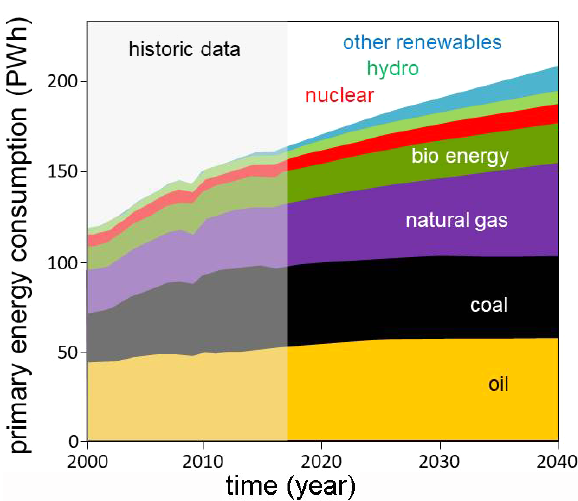
Fig. 4. – Primary energy consumption vs. time. The range of the historical data is indicated. The rest up to 2040 are the outcome of the IEA New Policies Scenario, NPS. The graph is reproduced from the IEA Outlook